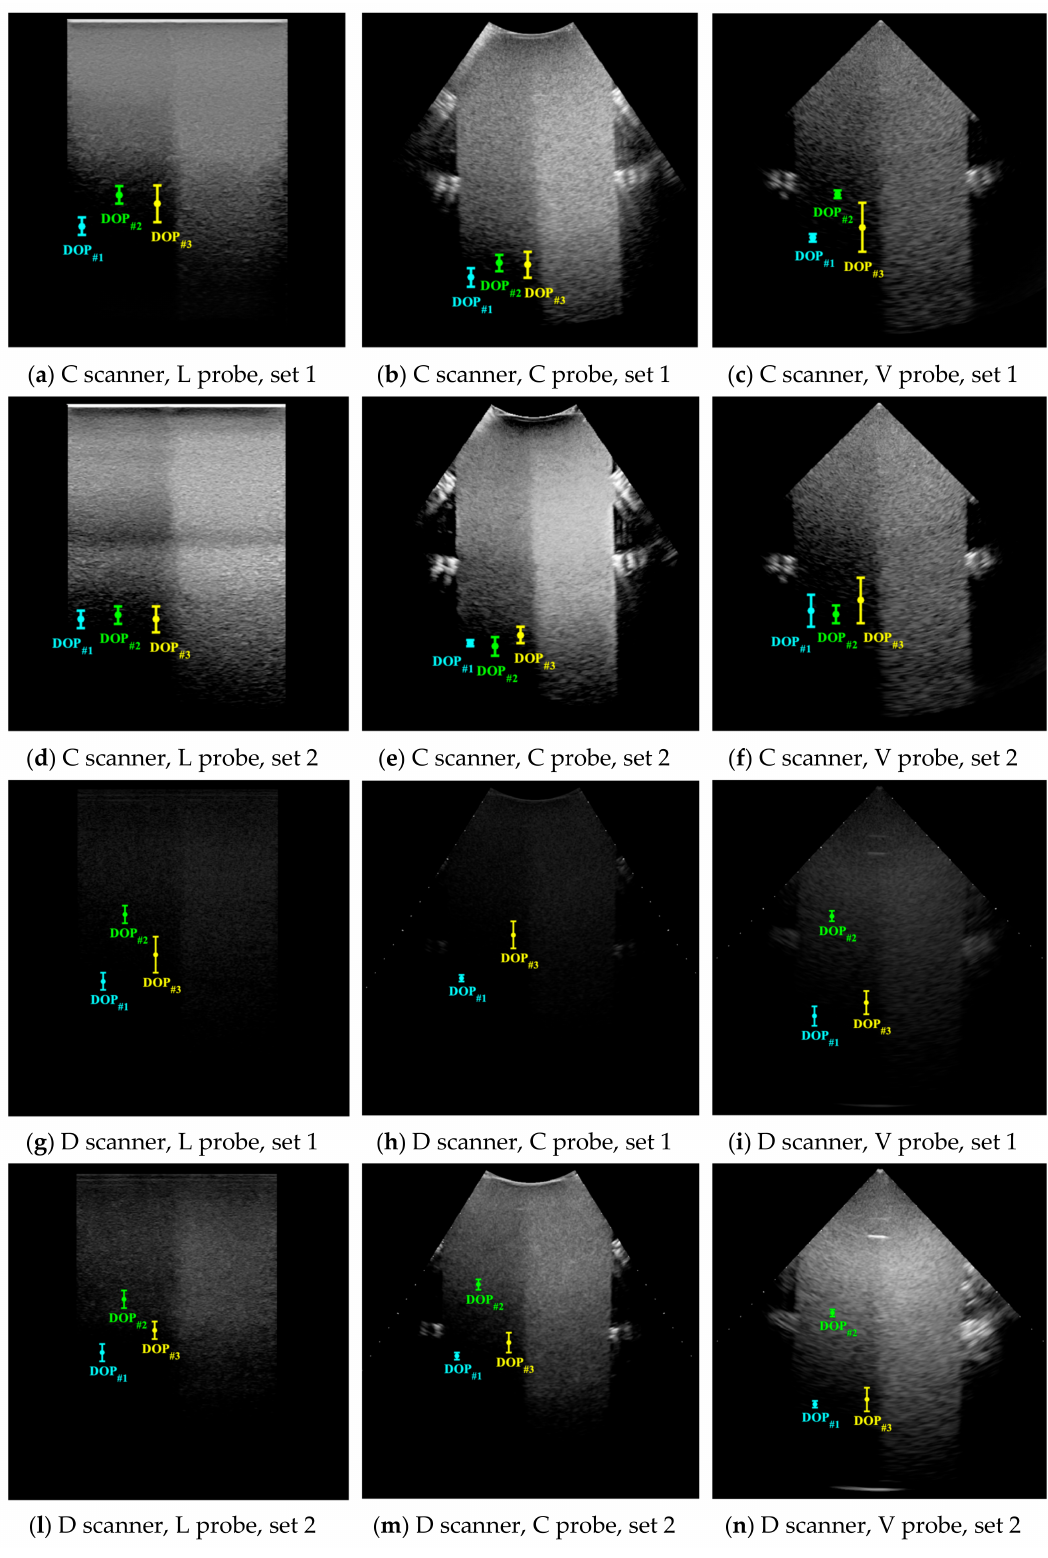
Figure 2. Depth of penetration for C and D diagnostic systems equipped with linear L, convex C, vector V probes tested in sets 1 and 2. DOP #1 and DOP #2 have been evaluated through the AdSTM and the TTM [18], respectively, while DOP #3 was assessed by naked eye. DOP values are represented with related error bars due to the total uncertainties reported in Table